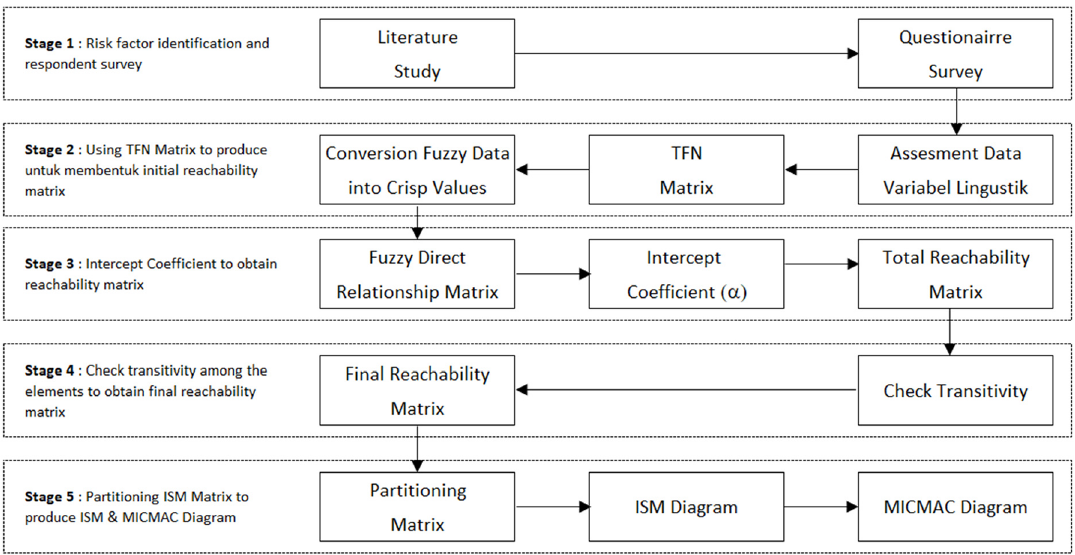
Figure 2. Research methodological